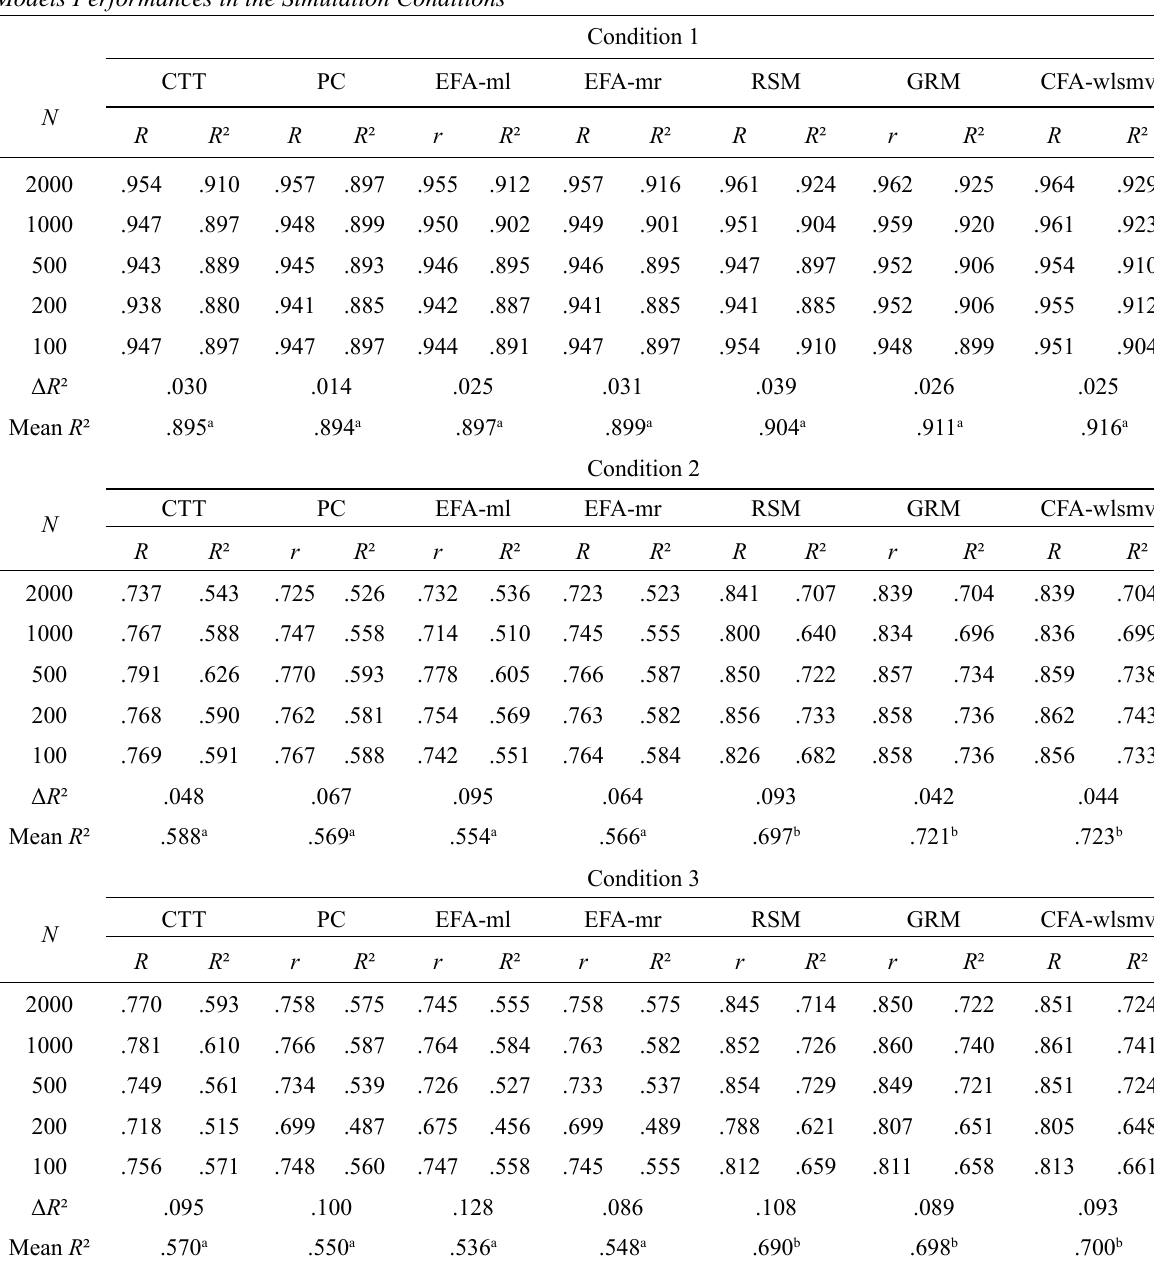
Models Performances in the Simulation